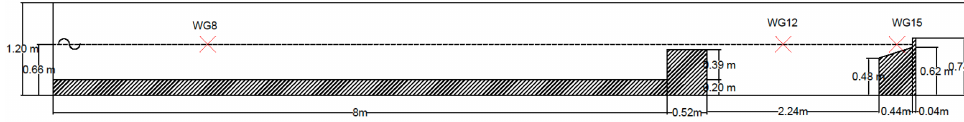
Figure 4. Configuration of the numerical wave tank in